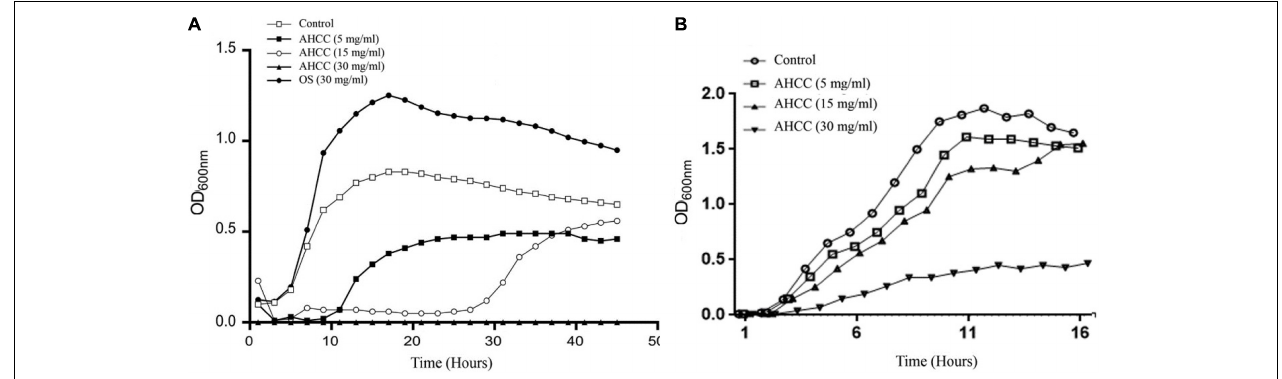
FIGURE 1 | Effect of AHCC R (cid:13) on the growth of P. aeruginosa . The growth curves in minimal medium M9 (A) and complete medium BHI (B) in the absence and presence of AHCC R (cid:13) at 5, 15 and 30 mg/mL are shown. As a control for the use of oligosaccharides as a carbon source when bacteria were grown in minimal medium M9 20 mg/mL of goat milk oligosaccharides (OS) was used. Growth curves were recorded at 37 ◦ C for 24 h. Representative data from one of three independent experiments with similar results are shown.